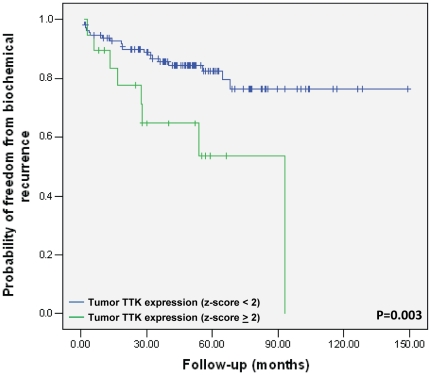
Higher TTK expression is associated with biochemical recurrence.Kaplan Meier plot of the risk of biochemical recurrence in patients (n = 131) with TTK overexpressing prostate tumors (n = 20; green line) versus those without TTK overexpressing (n = 111; blue line) tumors (p = 0.003, log-rank test).